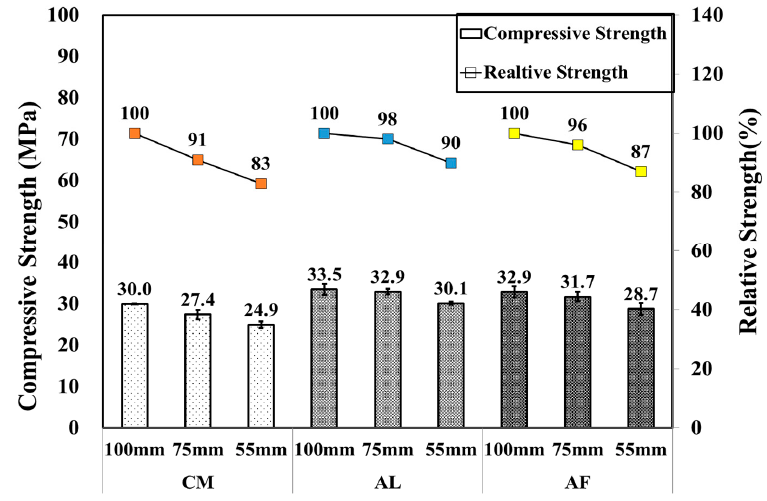
Figure 4. Core compressive and relative strengths of SH specimens by accelerators for 1 month-old specimens.